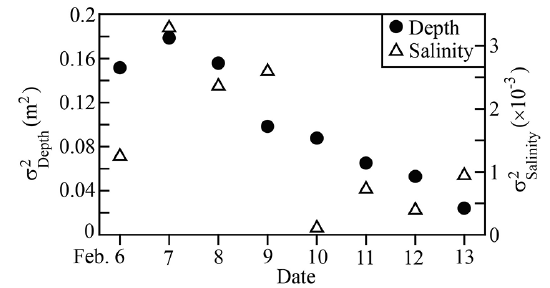
Figure 2. Daily variance of water depth ( σ 2 ( σ 2 ) at the coastal reef station CT during 6–13 February 2012. Salinity